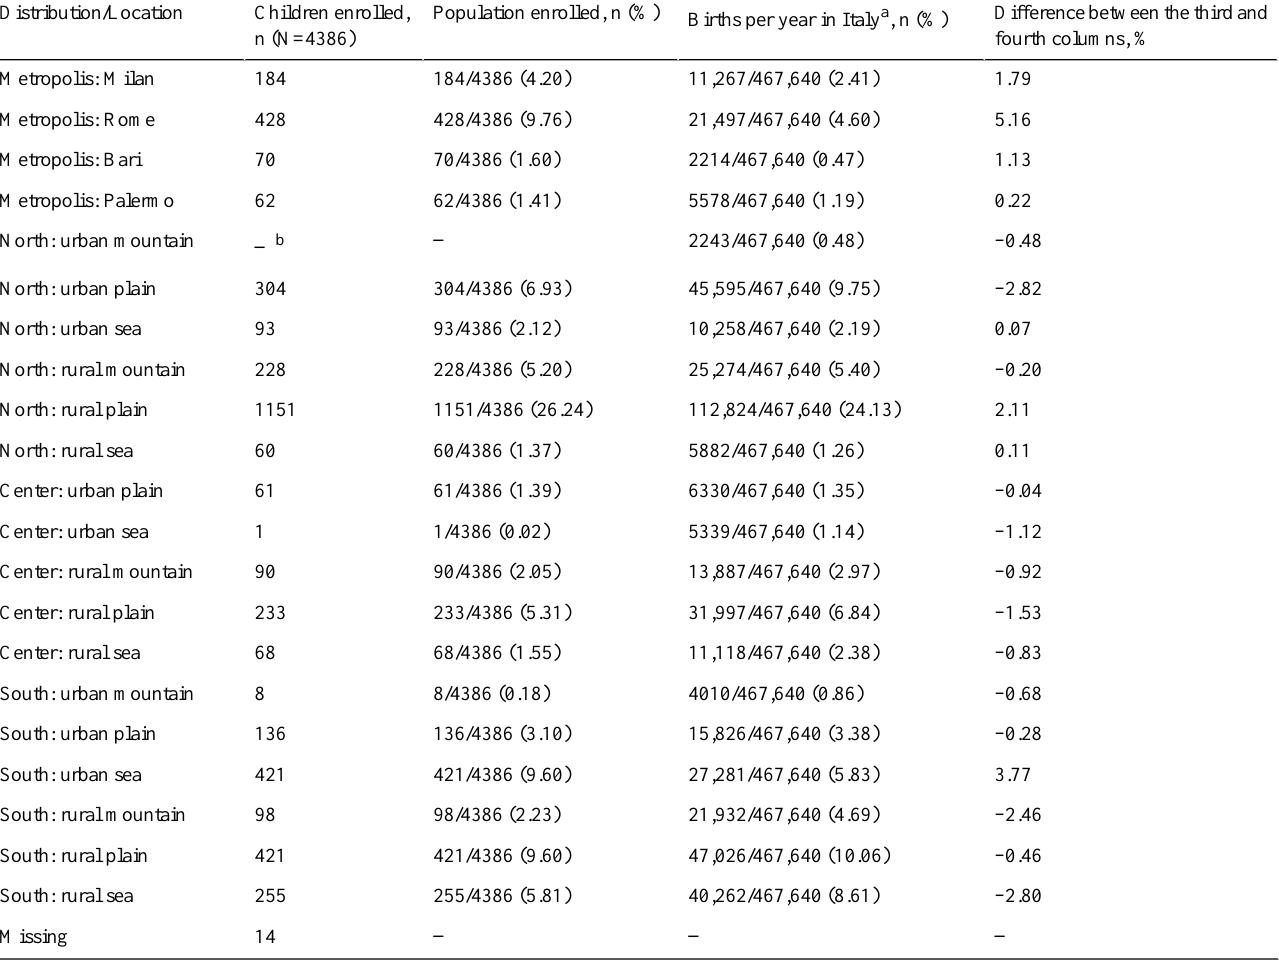
Table 2. Distribution of the number of children and the number of children born in each cluster and geographic area.